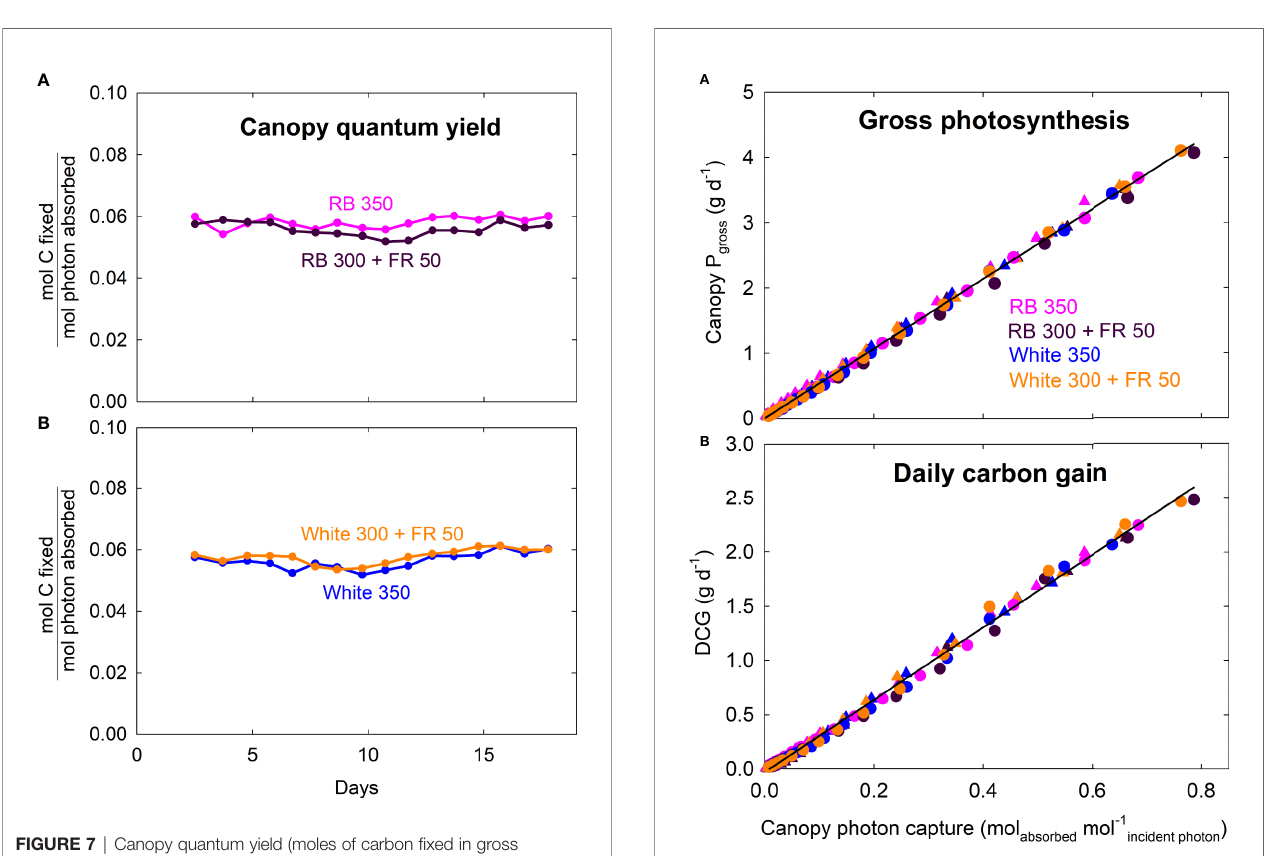
FIGURE 8 | Canopy gross photosynthesis (P gross ) and daily carbon gain (DCG) as a function of canopy photon capture of lettuce. Canopy P gross (and DCG) of all four treatments increased linearly with increasing photon capture and had a common slope. RB, red and blue; FR, far-red. The numbers following each type of light ( e.g. RB 350) indicate photon fl ux density in m mol m − 2 s − 1 . Circles represent data from Rep 1, and triangles represent data from Rep 2 (see DCG in Figure 3